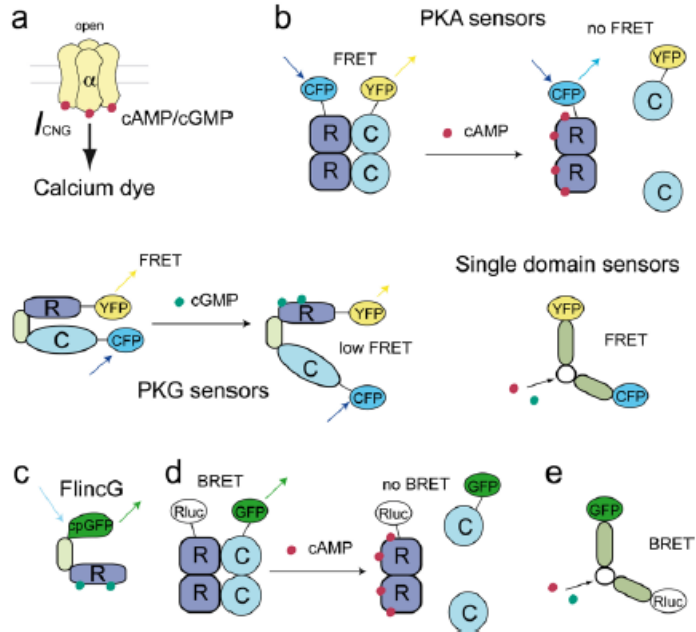
Figure 1. Common principles of biosensors designed to measure cAMP and